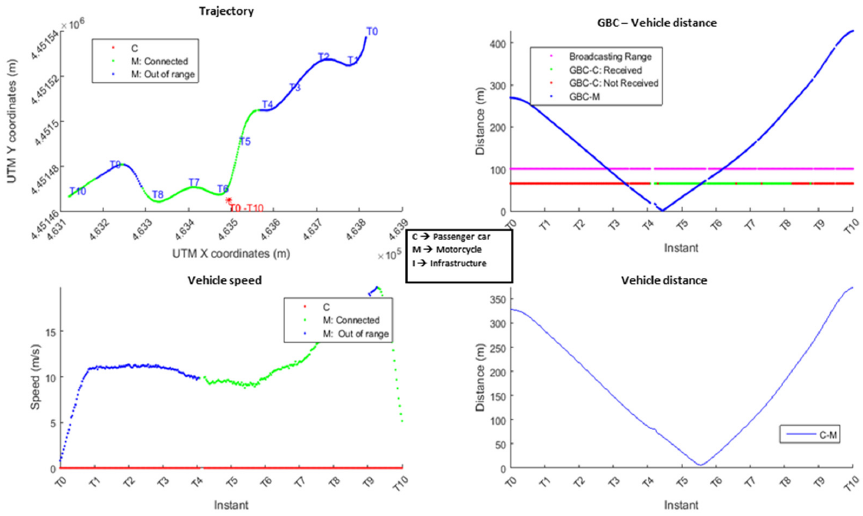
Figure 8. Results of Test 4 without RSU.